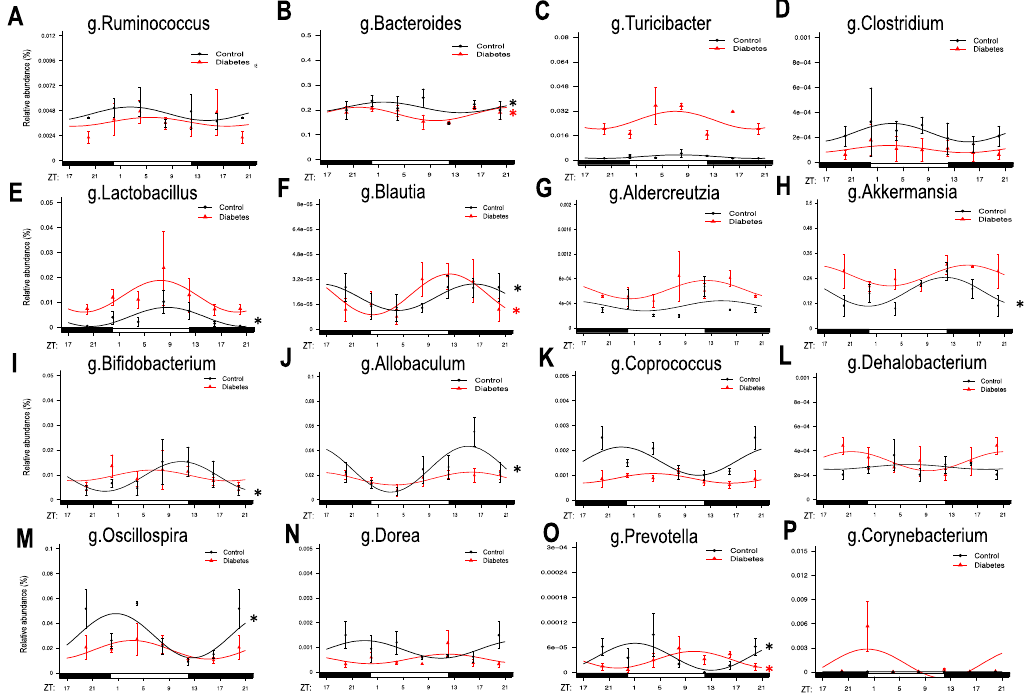
Figure 1. Diurnal oscillatory rhythms of the gut microbiota at the genus level in type 2 diabetes. Bacterial 16SrRNA sequence analysis was performed in fecal samples from 10 month old db / db (red) and aged-matched controls, db / m (black) collected every 4 h for a 24-h period at ZT0, ZT4, ZT8, ZT12, ZT16, ZT20. ZT indicates zeitgeber time, i.e., hours after the lights are on. ( A – P ) Identified OTUs belonging to each genus were summed up and cosinor analysis was performed for each genus. n = 3 per time point per group. Asterisks indicate the genera that exhibit significant oscillatory rhythmicity using the zero -amplitude test with a p -value of less than 0.05.